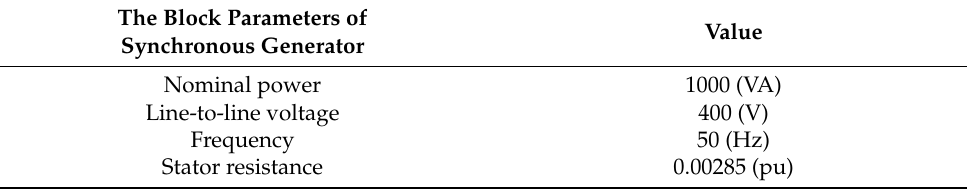
Table 4. The block parameters of the designed synchronous generator.